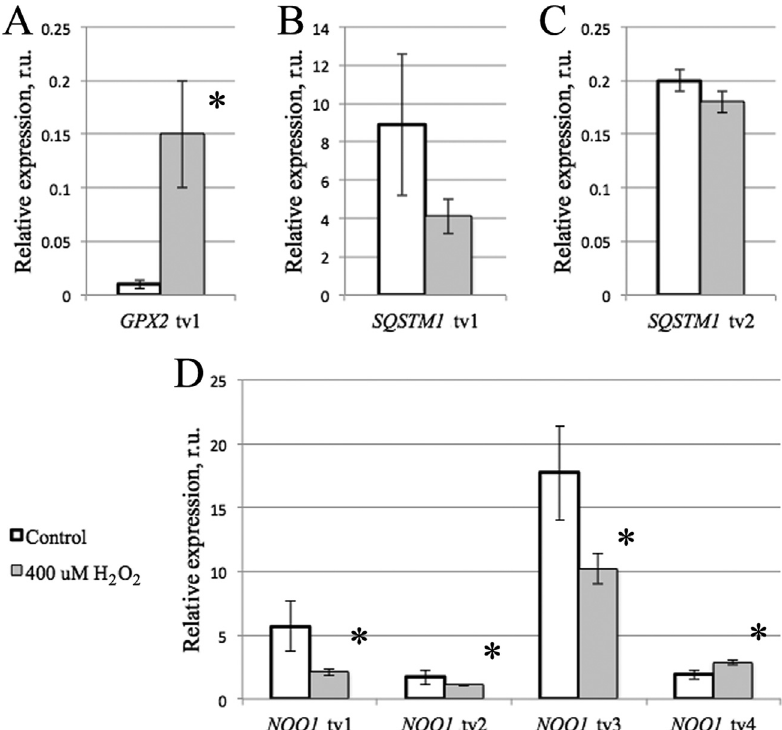
Figure 4 - Character of expression of GPX2 (A), SQSTM1 (B, C) and NQO1 (D) transcript variants. * - p < 0.05 - differences are significant in at least one of the normalization